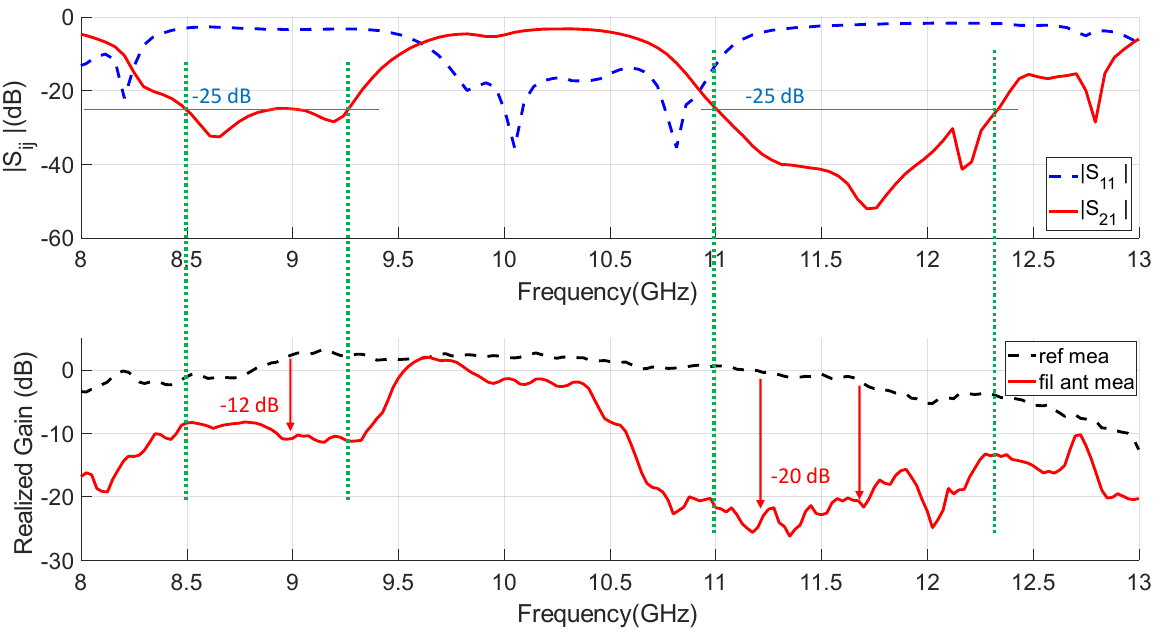
Figure 21. Comparison of the measurements obtained for the stand alone EBG filter frequency response (based on five-cell EBG) and the broadside realized gain of the proposed integrated IM- GWG filtering antenna (based on three-cell EBG).